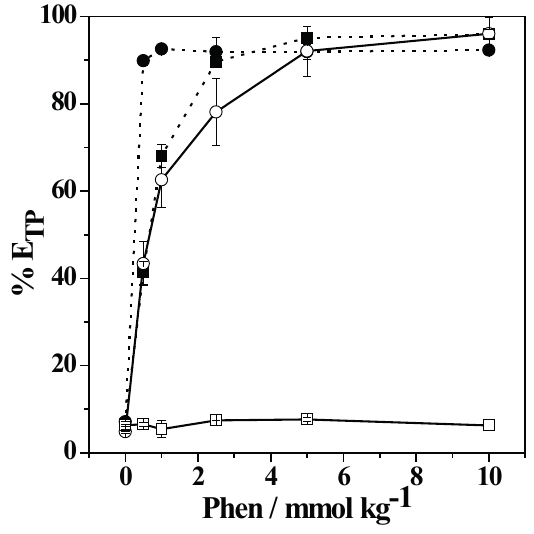
Figure 4 - Effect of electrolyte nature and 1,10-phenatroline (phen) quantity added to theATPS on the %E TP of iron species: ( (cid:4) ) Fe(II) and ( (cid:3) ) Fe(III) at PEO1500 + Na 3 C 6 H 5 O 7 + H 2 O ATPS; ( • ) Fe(II) and ( ◦ ) Fe(III) at PEO1500 + Na 2 SO 4 + H 2 O ATPS; [iron] = 0.100 mmol kg -1 ; pH = 6.00; T = 25.0 °C; n =